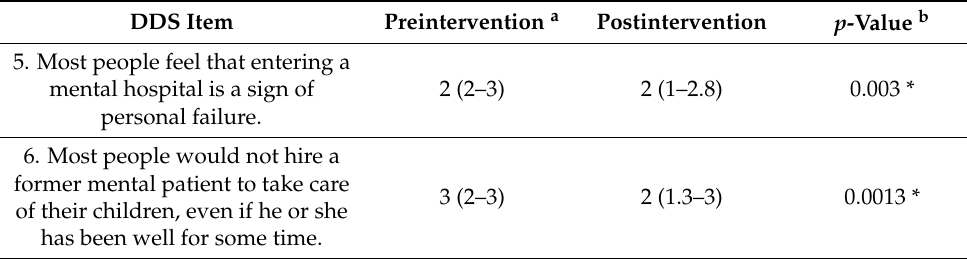
Table 4. Comparison of students’ DDS subitem scores between pre- and postintervention periods ( n = 28). DDS